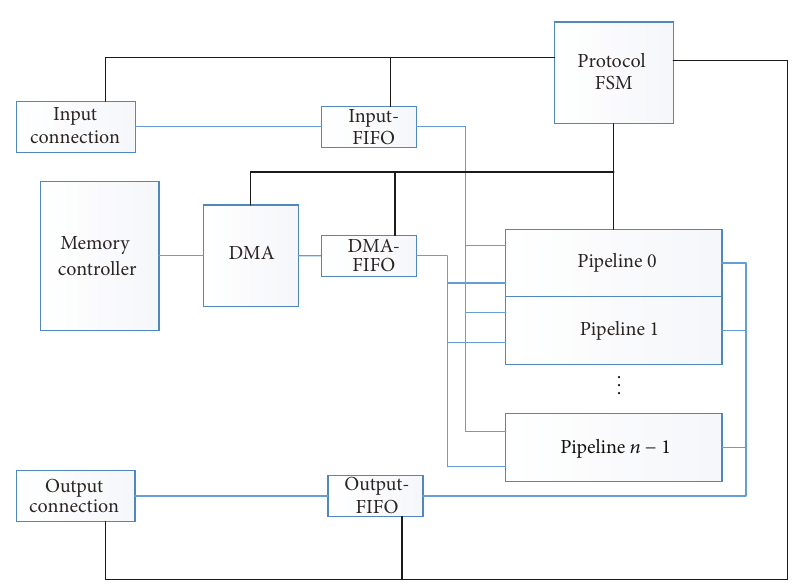
Figure 12: Protocol’s hardware implementation.